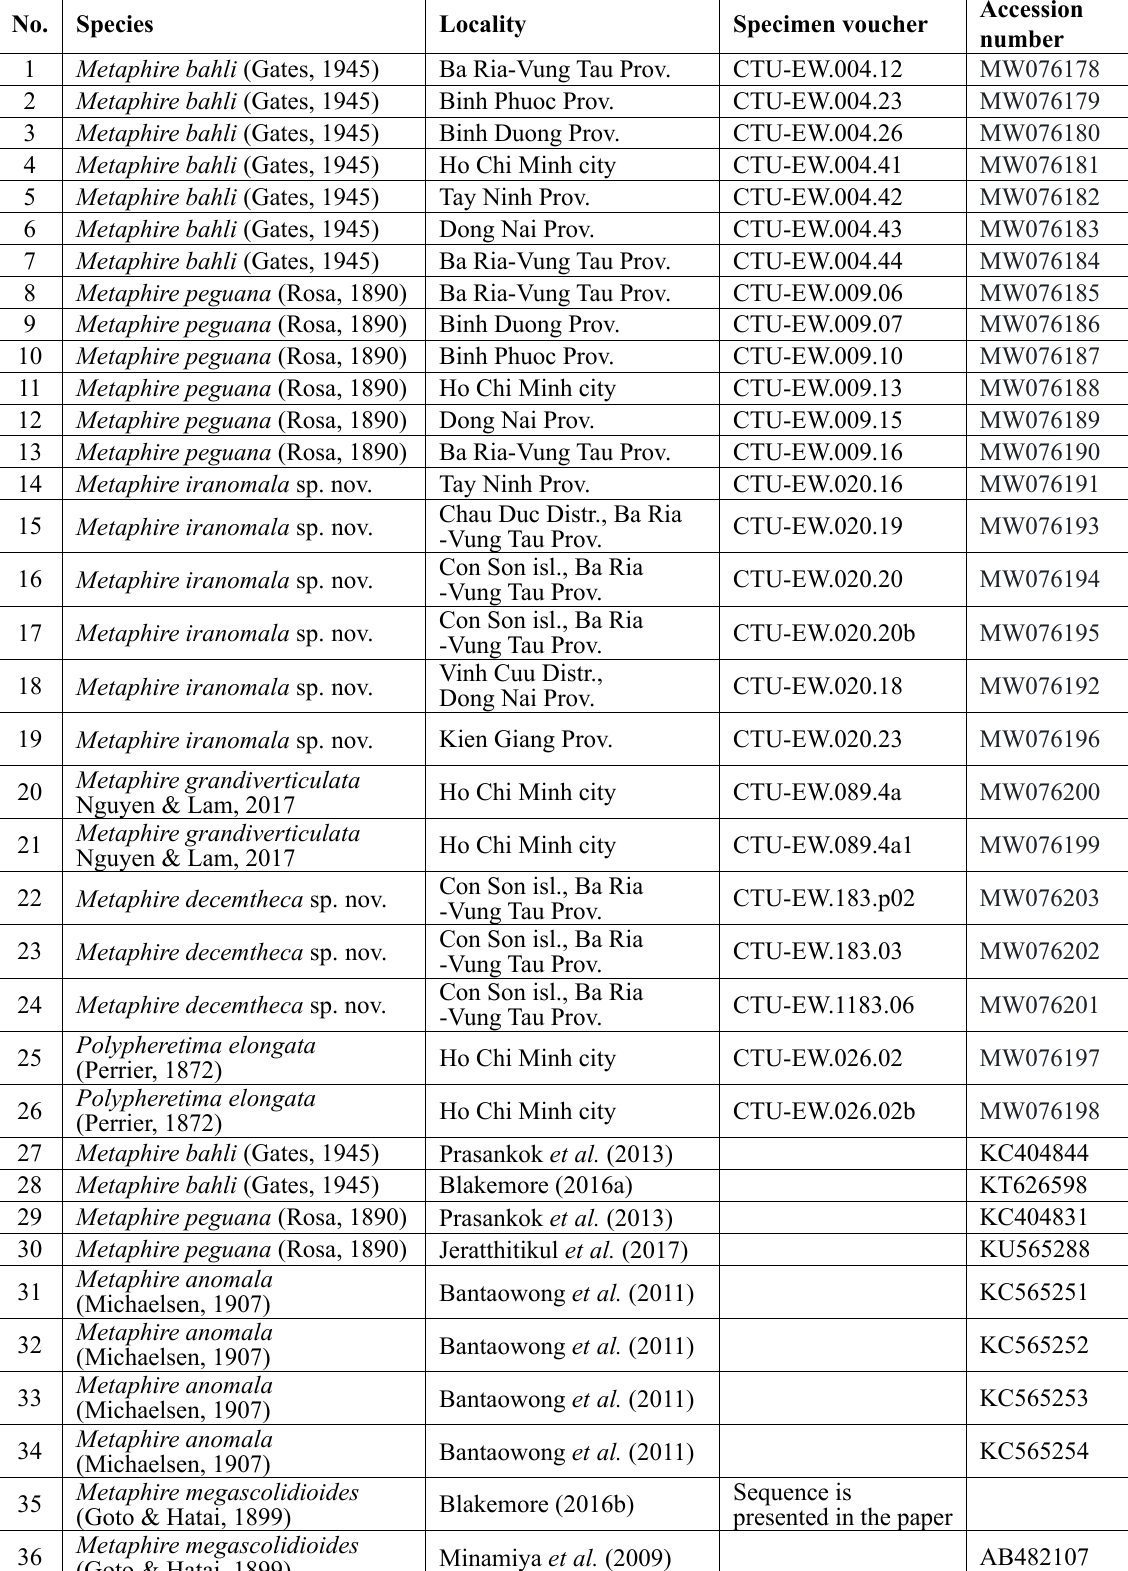
Table 1. Specimen vouchers and accession numbers deposited in